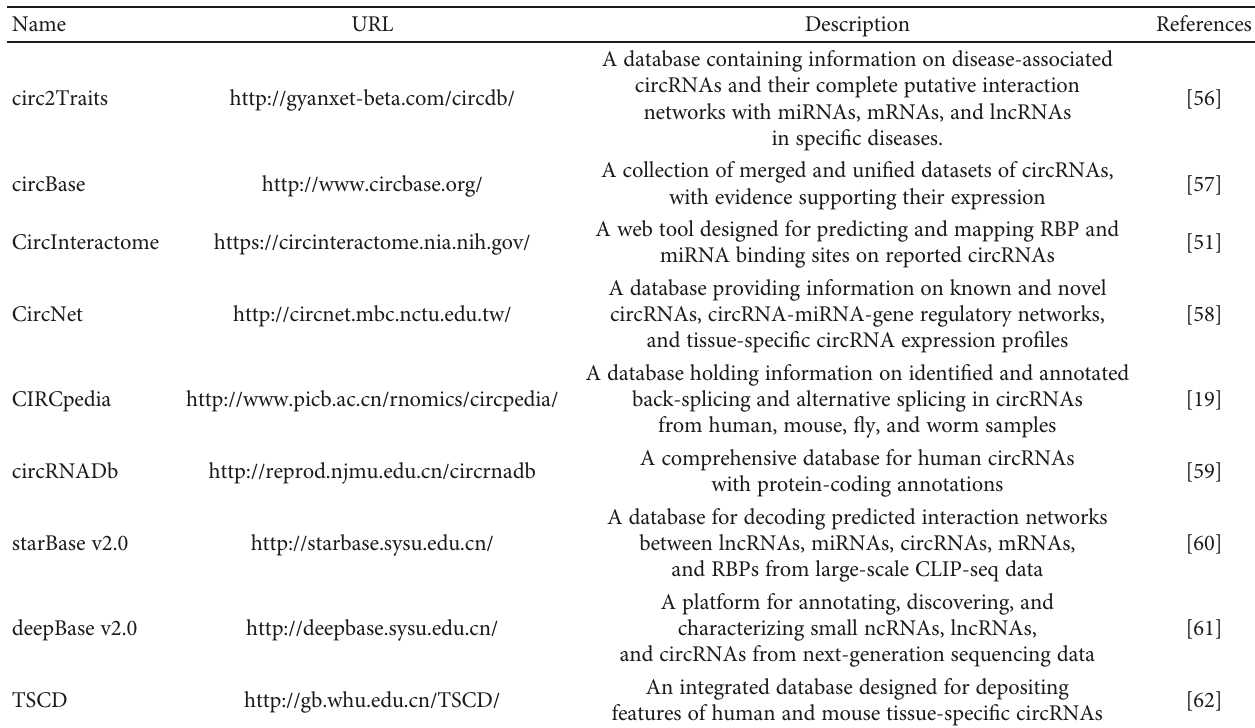
Table 1: Databases containing circRNA